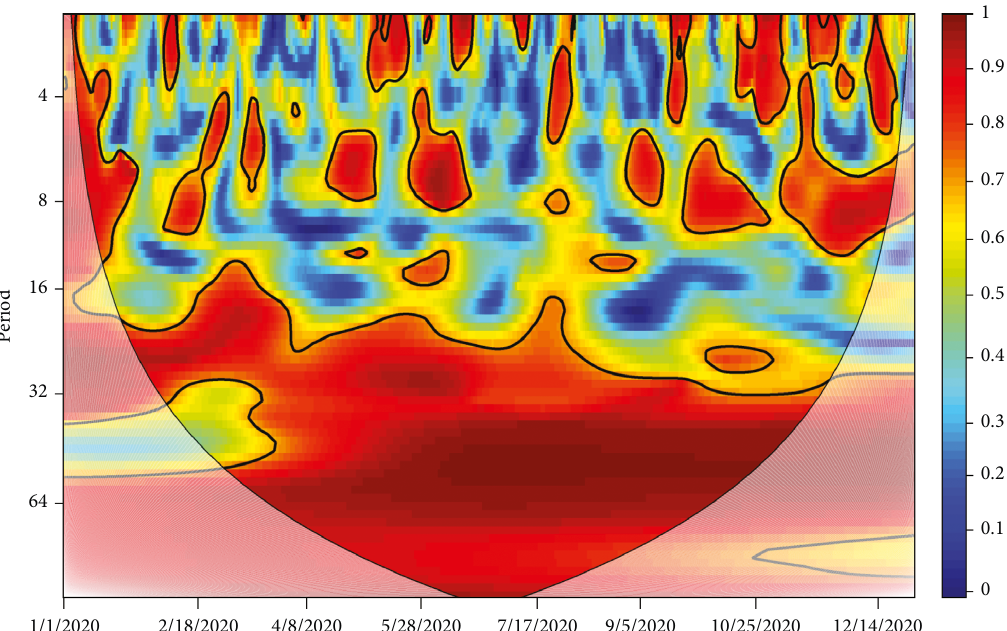
Figure 3: The combined effect of EPU and VIX on illiquidity (tranquil period). Note: this figure represents the combined effect of between EPU and VIX on US illiquidity during tranquil period. The black contour represents the regions in which the spectrum is significant at the 5% level against red noise. The cone of influence denoted as COI is designated by the lighter shade which delineates the high power regions. Time and scale (days) are represented on the horizontal and vertical axes, respectively. Arrows pointed to the right (resp. left) signify that the variables are in phase (out of phase). If arrows move to the right and up (resp. down), the first variable is the driver (resp. follower). By contrast, if arrows move to the left and up (down), the second variable is leading (resp.